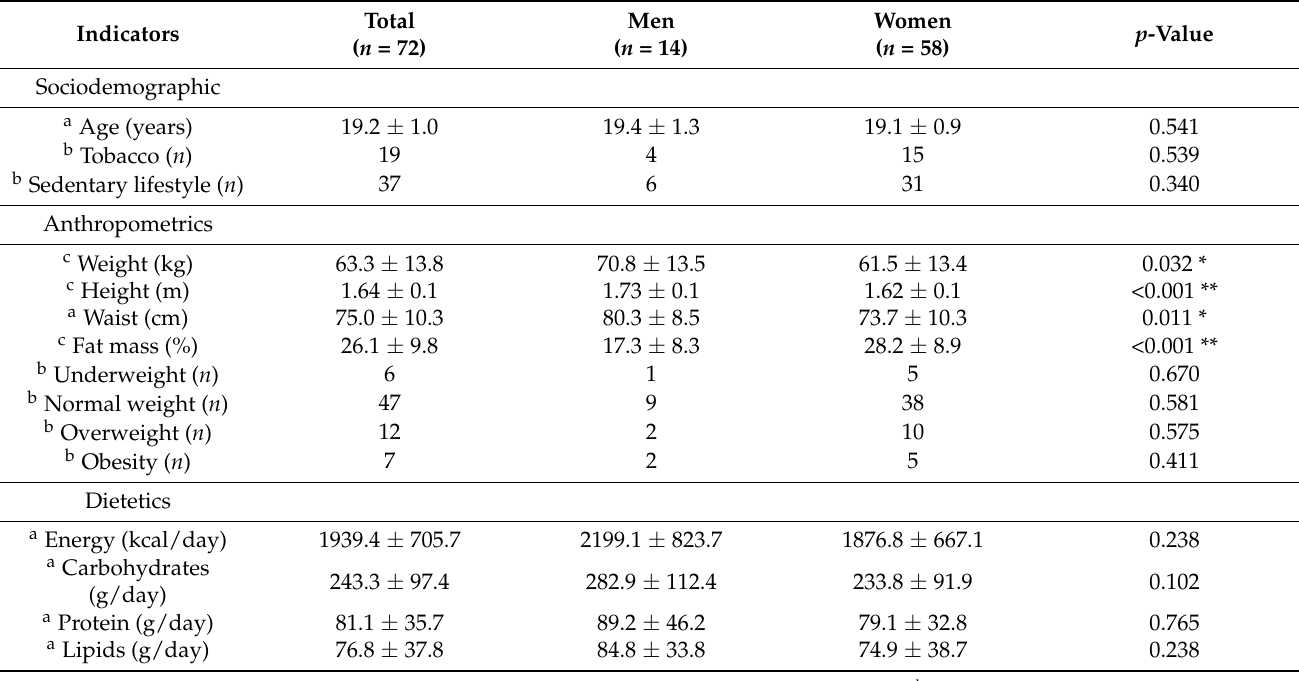
Table A1. General characteristics of the population evaluated regarding their